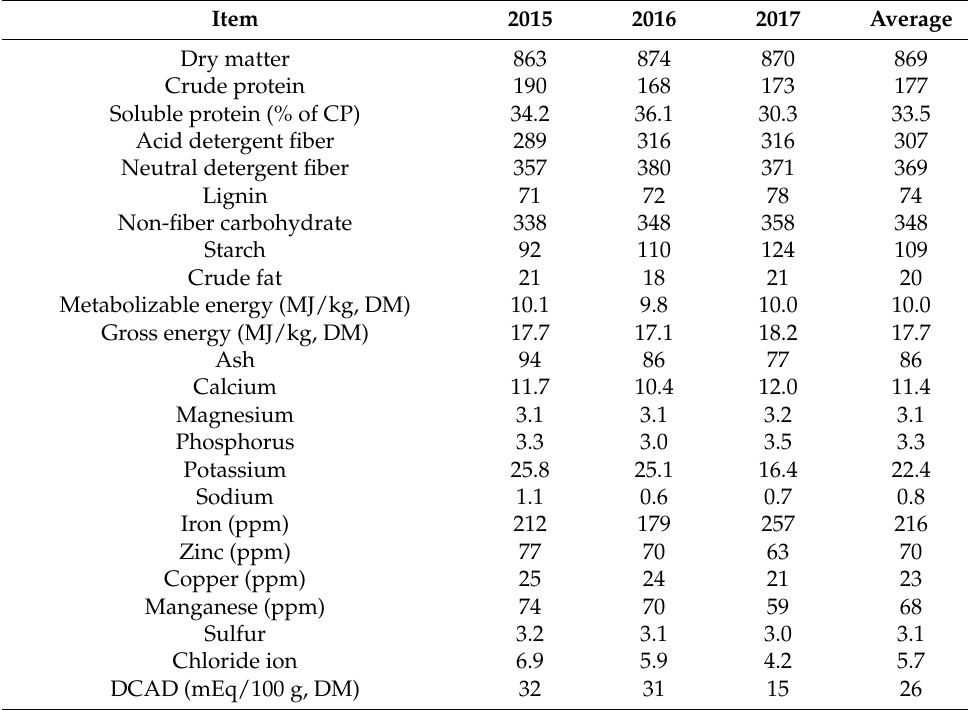
Table 1. Composition of the diet. Units are (g/kg, DM) unless otherwise